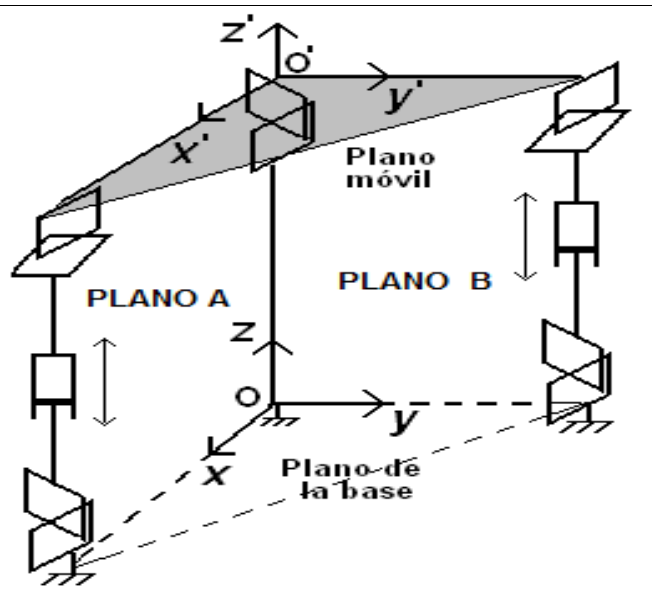
Figura 2: Orientaciones del Vehículo en el Espacio. Fuente: Autores,